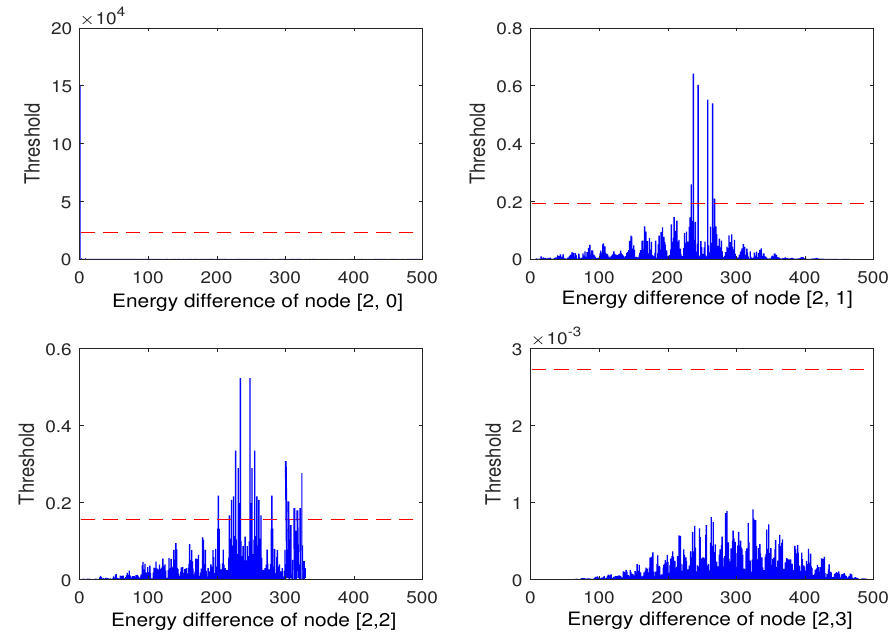
Figure 11. Energy difference result of second layer